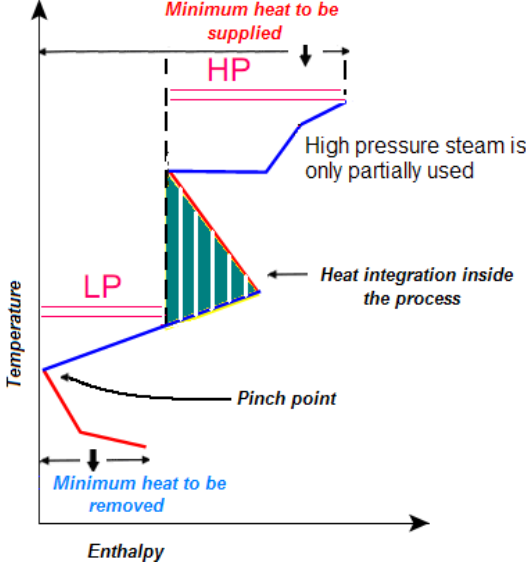
Figure 4. Reduced use of high pressure steam.